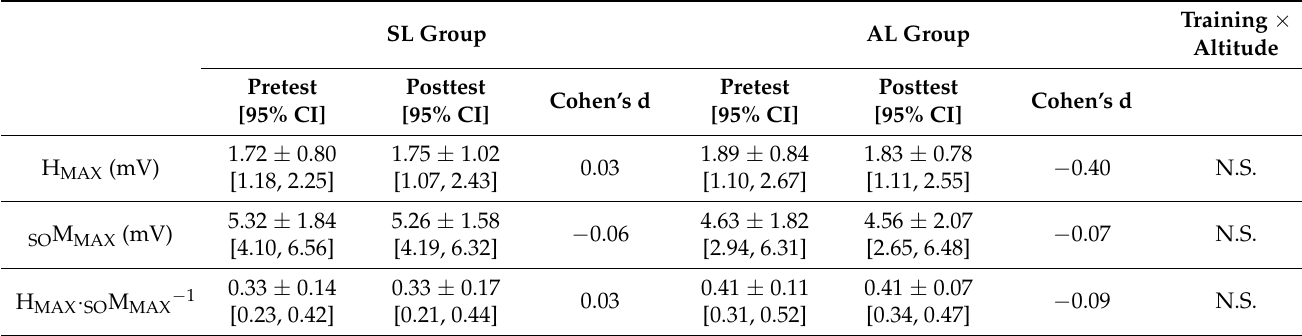
Table 5. Spinal excitability before and after explosive and endurance strength training in elite judo athletes.